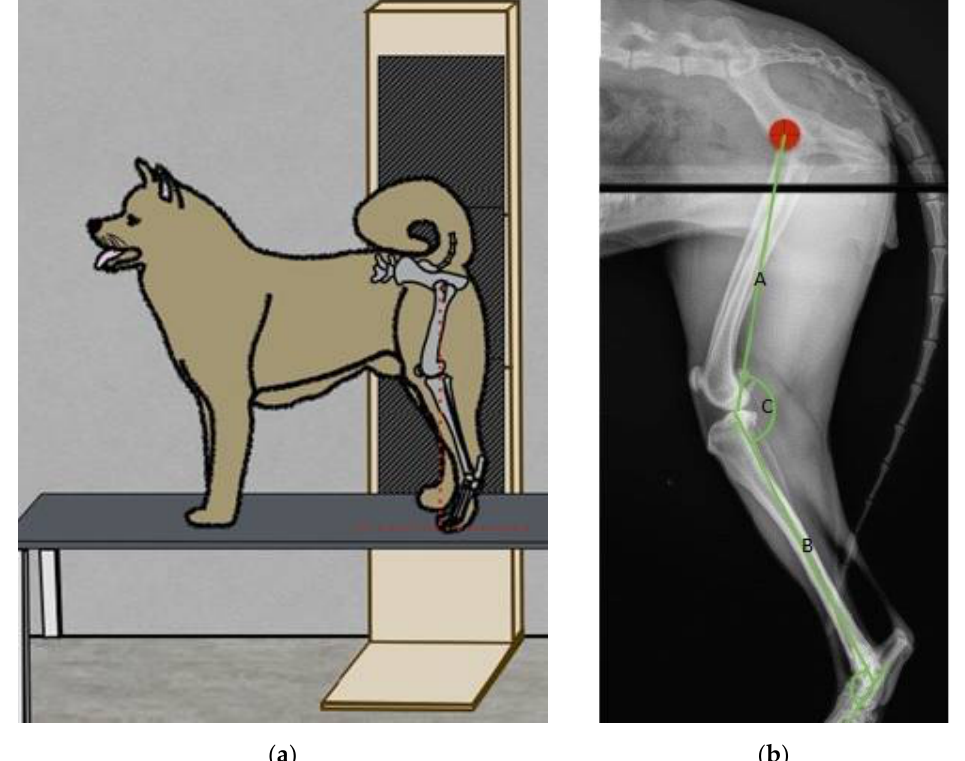
Figure 1. ( a ) Schematic representation of the custom-made cassette holder and positioning of the dog during radiograph processing. ( b ) Mechanical axis on radiographs (A: femur; B: tibia; C: stifle angle).